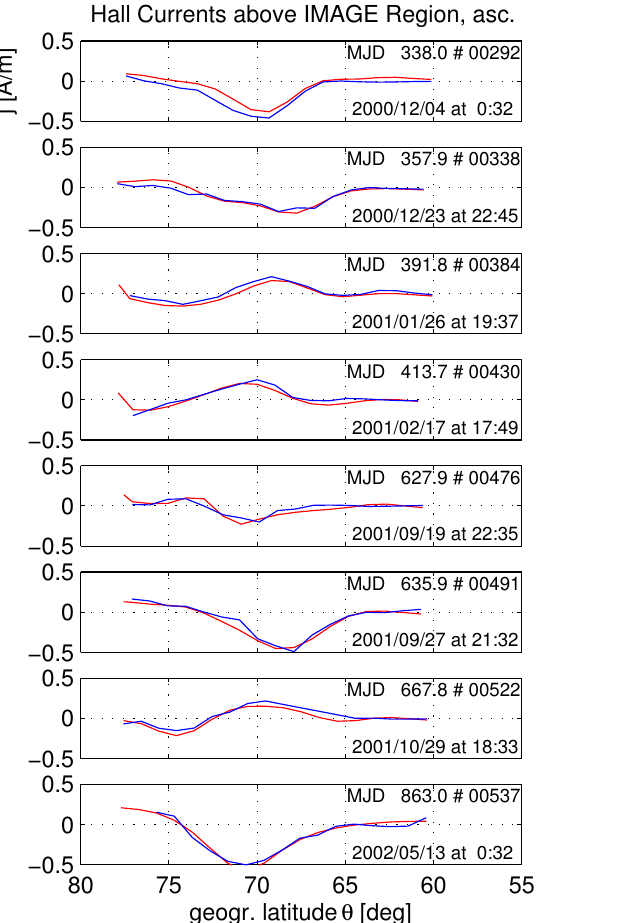
20011106 05:07:40